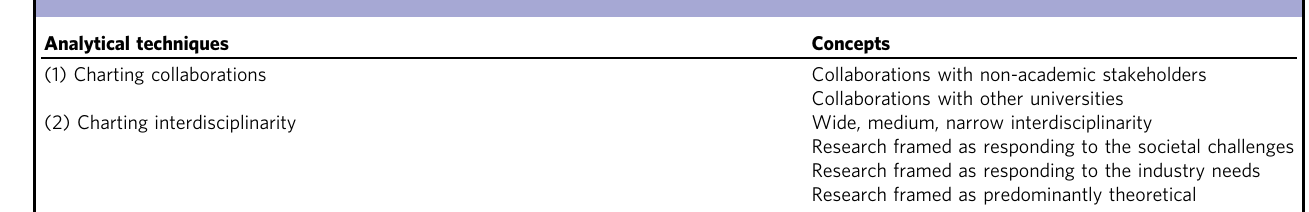
Table 2 The analytical framework for content